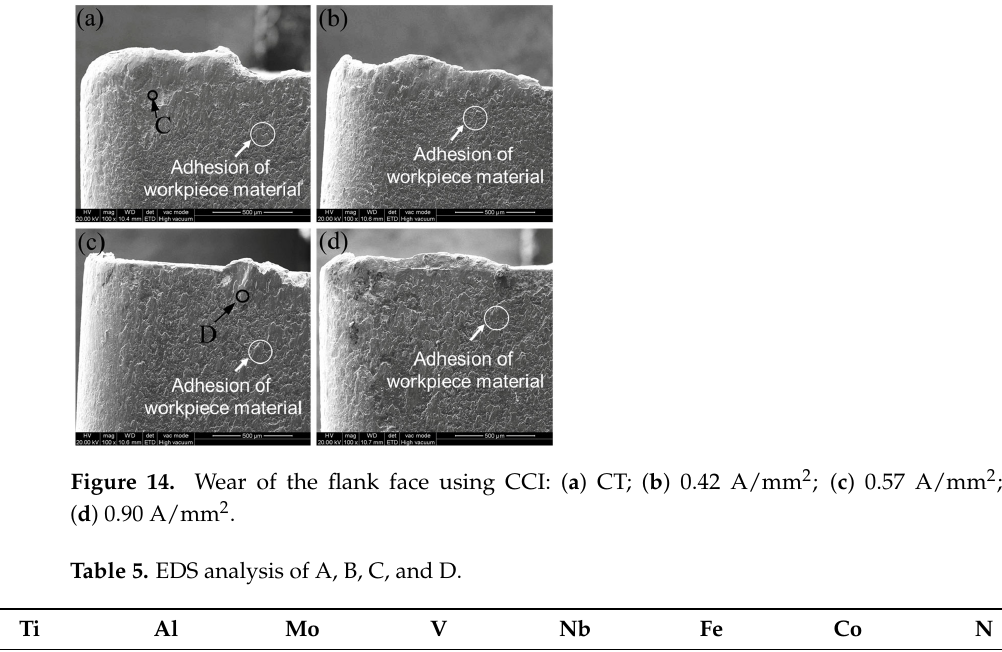
Figure 13. Wear of the fl ank face using UCI: ( a ) CT; ( b ) 0.42 A/mm 2 ; ( c ) 0.57 A/mm 2 ; and ( d ) 0.90 A/mm 2 .